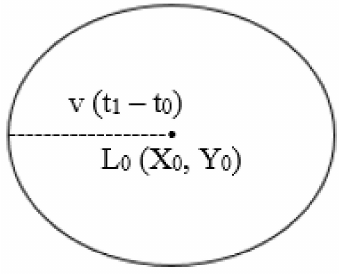
Figure 3. The expected zone.